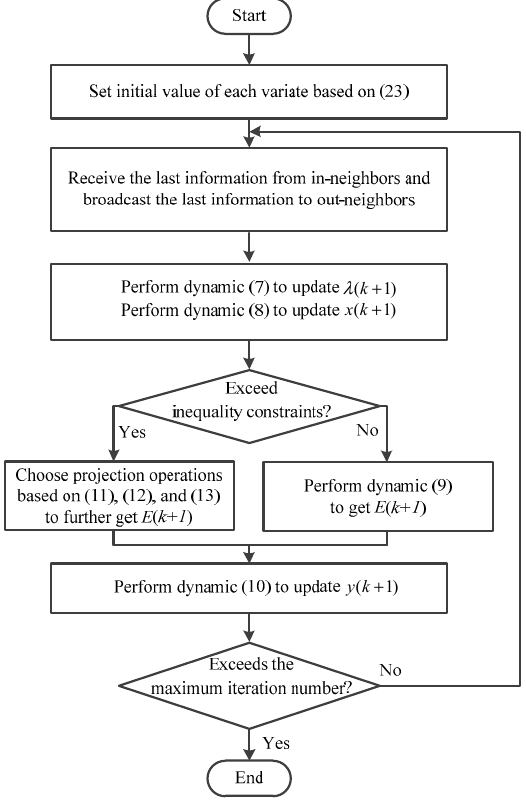
Figure 2. Flowchart of the proposed DDC algorithm.